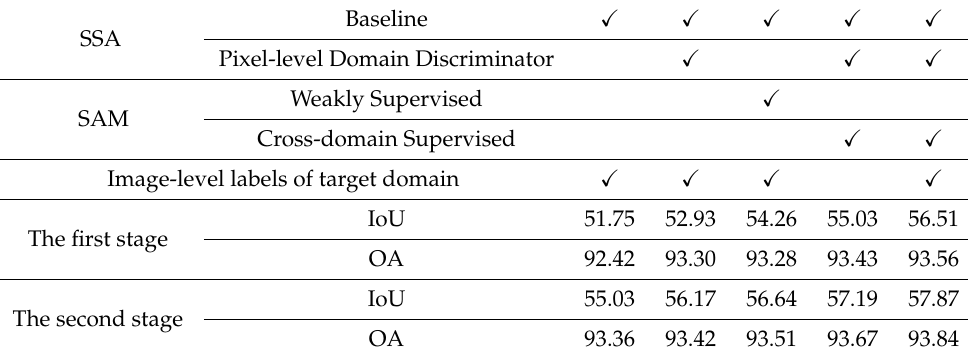
Table 1. A Ablation Experiments On WHU Data Set